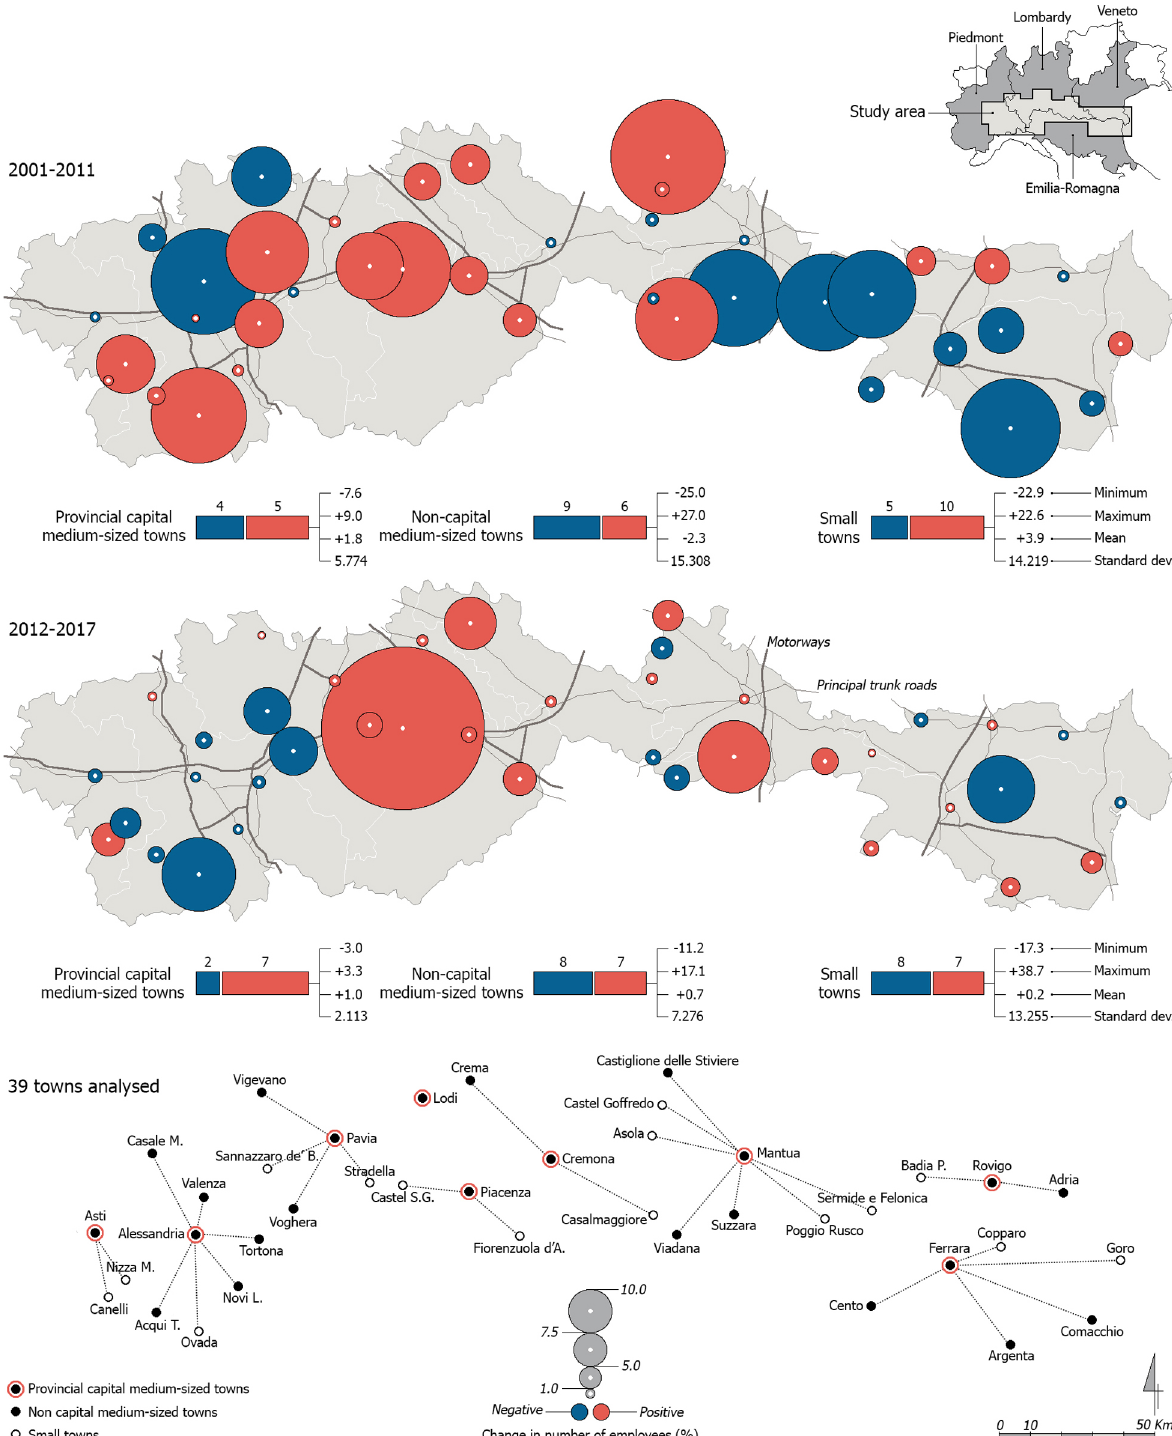
Fig. 1. Percentage change in the number of employees at local units in the 39 towns analysed (2001–2011,